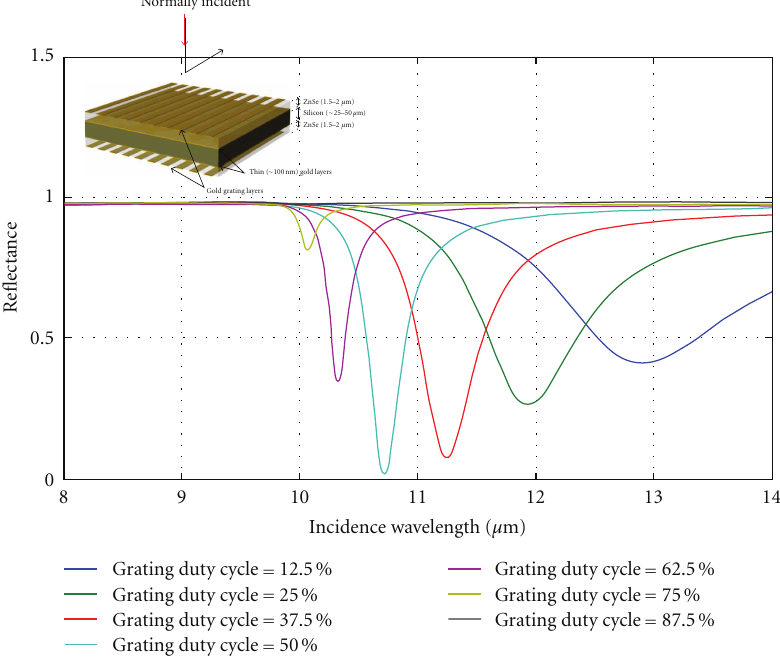
Figure 6: Simulation results using the RCW method that present the reflectance at normal incidence within the LWIR band as the duty cycle of the gold grating period is varied from 12.5% to 87.5%. For this simulation, the substrate thickness is fixed at 2.0 µ m with a grating period of 3.0 µ m. The incident wave was normally incident with parallel polarization.